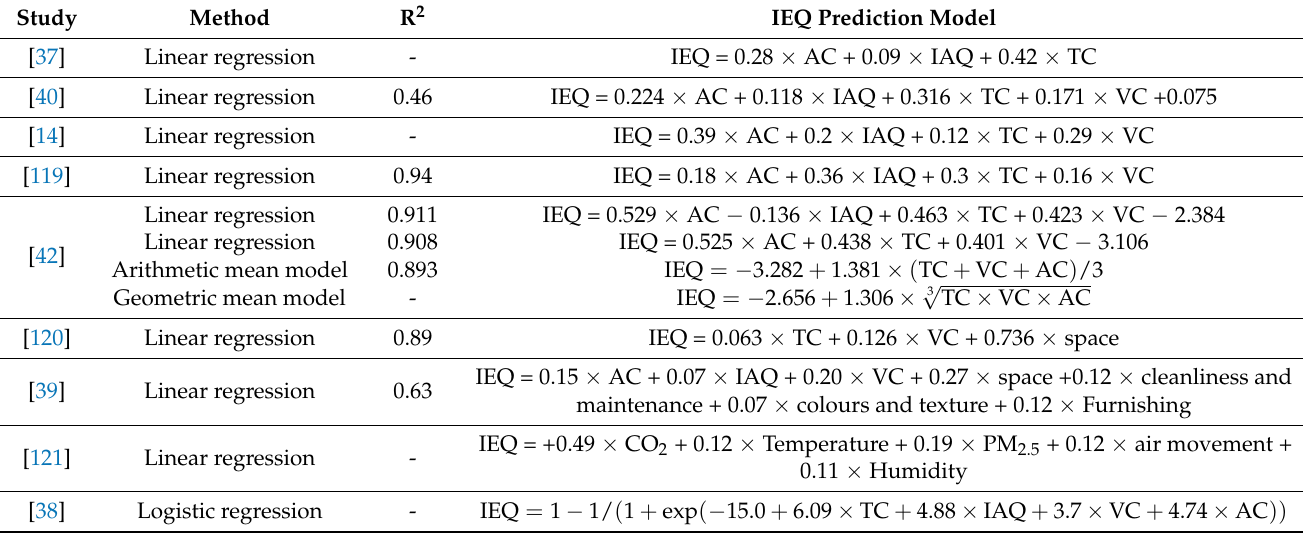
Table 6. IEQ models and indexes in